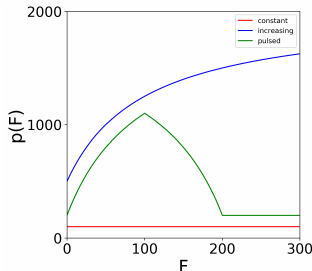
Figure 2. Secretion rate models. Profiles for the constant ( q 0 = 100), increasing ( q 0 = 500, q 1 = 2000, ¯ F = 100) and the pulsed ( q = 200, q = 2000, ¯ F = 100) secretion rate models. The models specify 0 1 the cellular secretion rate ( q ( F ) ) as a function of the extracellular IFN level ( F ). For the increasing and pulsed model, q ( ¯ F ) = ( q 0 + q 1 ) /2. For the pulsed model, the maximum secretion rate is achieved at ¯ F .